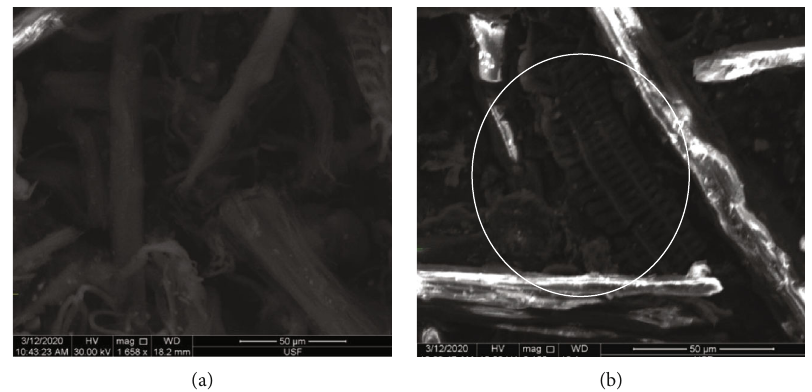
Figure 2: SEM images of sisal fi bers: (a) untreated (USF) and (b) treated (TSF).